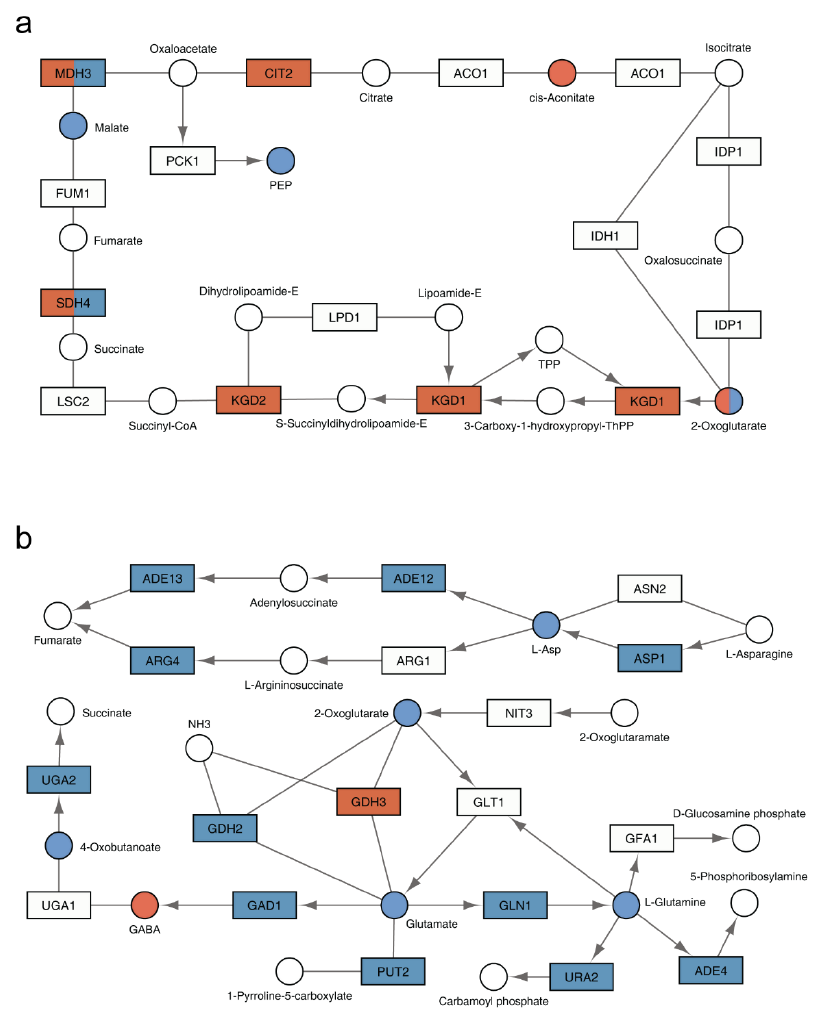
Figure 4. KEGG pathways regulated by GPR1 or SNF3 and RGT2 . Regions of interest in the KEGG pathway are shown with genes displayed as rectangles and metabolites displayed as circles. KEGG compound name for each metabolite is labeled beside the circle. Standard gene names are labeled inside the rectangle. For enzyme complexes, the gene name for the major component is shown followed with an ellipsis. The directions of irreversible enzymatic reactions are shown by the arrows. Reversible reactions are connected by straight lines. DEGs and SPMs are highlighted in red ( gpr1 Δ ) and blue ( snf3 Δ rgt2 Δ ). Shared DEGs and SPMs are colored half red and half blue. ( a ) as compared with snf3 Δ rgt2 Δ , gpr1 Δ affected more components in citrate cycle (TCA cycle, functional category: carbohydrate); ( b ) as compared with gpr1 Δ , snf3 Δ rgt2 Δ affected more components in alanine, aspartate and glutamate metabolism (showing aspartate and glutamate specifically, functional category: amino acid).